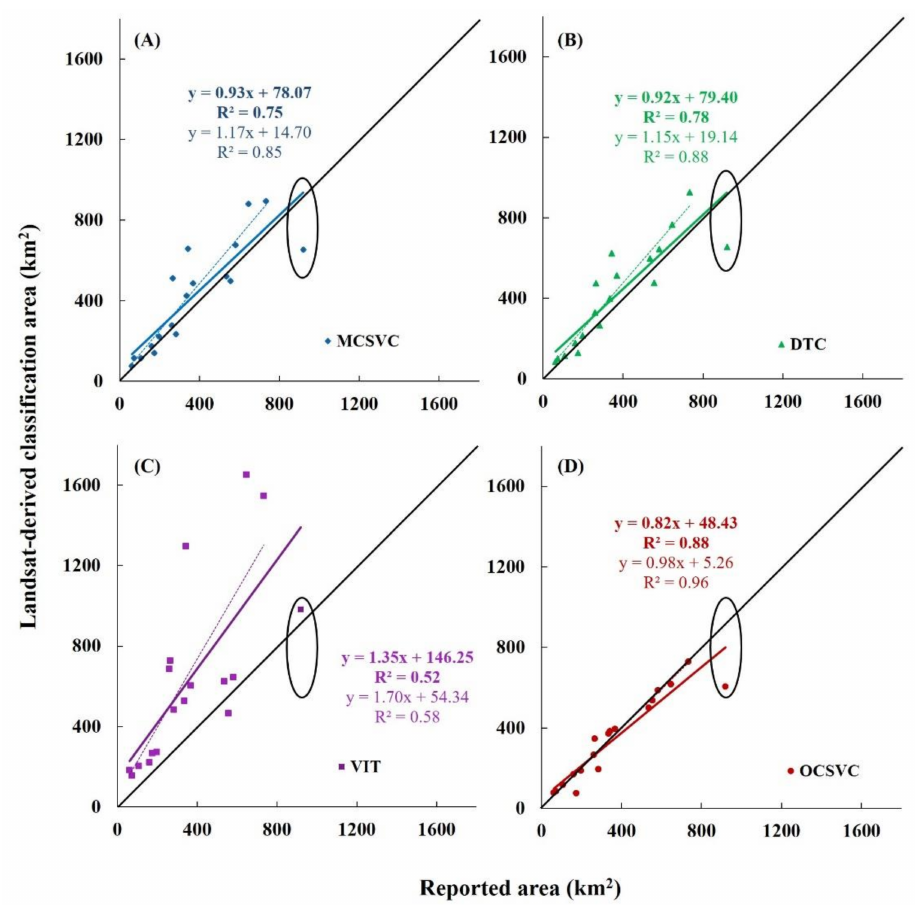
Figure 12. Comparisons of the reported area of 2016 from the agricultural statistics department of Jiangsu and classification area of the 18 case counties. Blue, yellow, purple, and red data points represent classifications obtained with MCSVC ( A ), DTC ( B ), VIT ( C ), and OCSVC ( D ), respectively. Solid trend lines correspond to the fitting for all case counties, while dashed ones correspond to the fittings excluding the circled data points. The black solid lines represent the 1:1